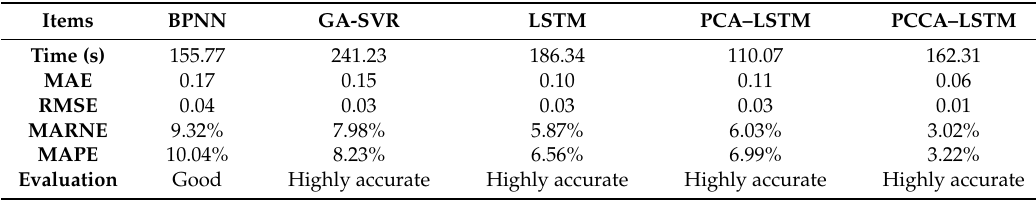
Table 3. The forecasting results in Xi’an case.